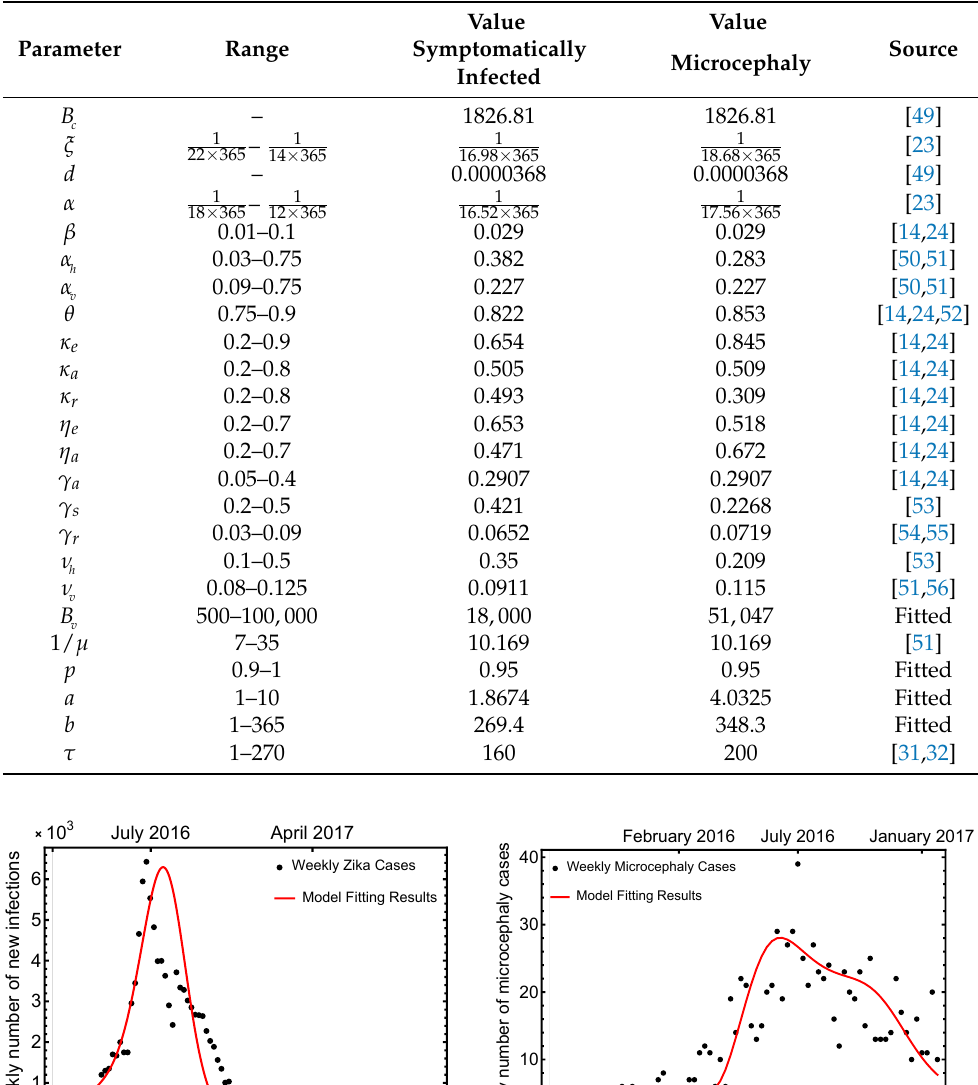
Table 2. Parameters, ranges and fitted values of model (1) in the case of Colombia.